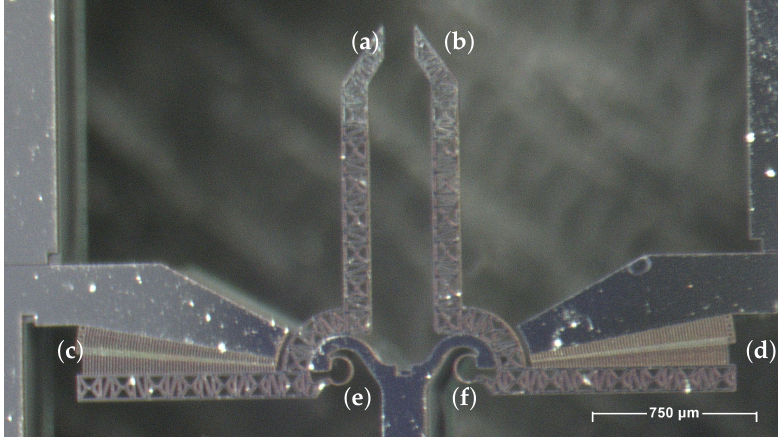
Figure 1. The Device Under Test (DUT): left ( a ) and right ( b ) jaws, left ( c ) and right ( d ) comb drives, and left ( e ) and right ( f ) CSFH